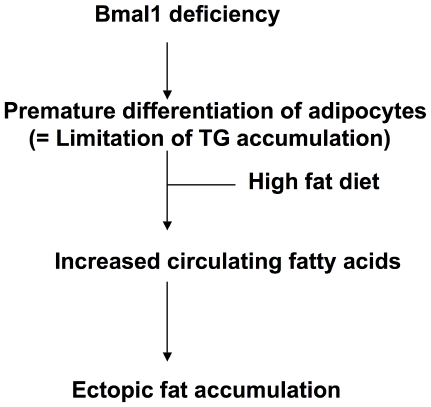
A schematic diagram of Bmal1 deficiency-induced abnormal lipid metabolism.